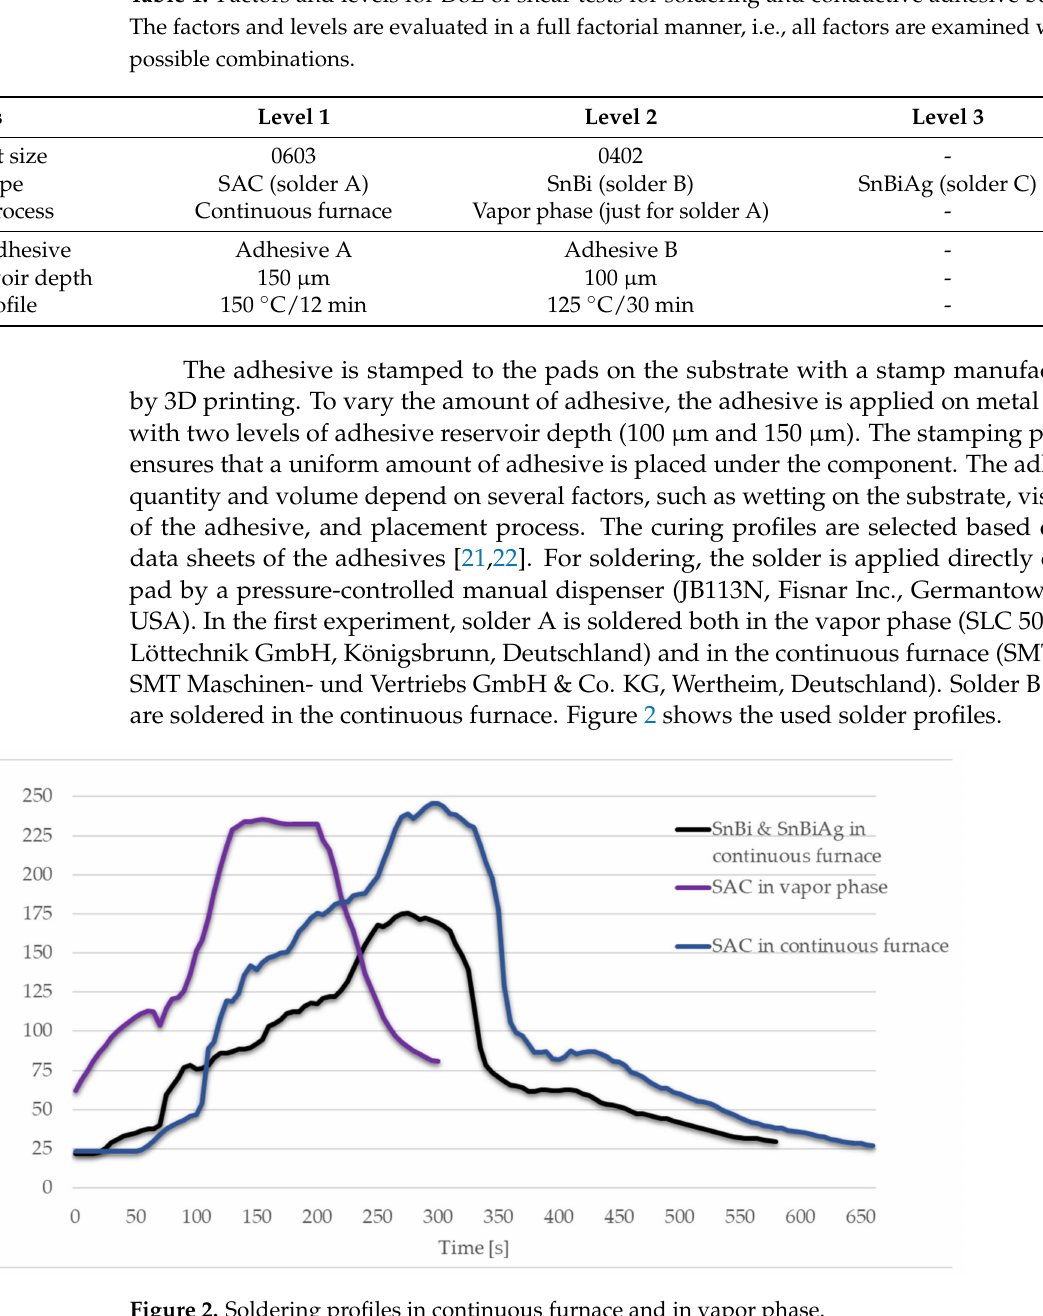
Figure 2. Soldering profiles in continuous furnace and in vapor